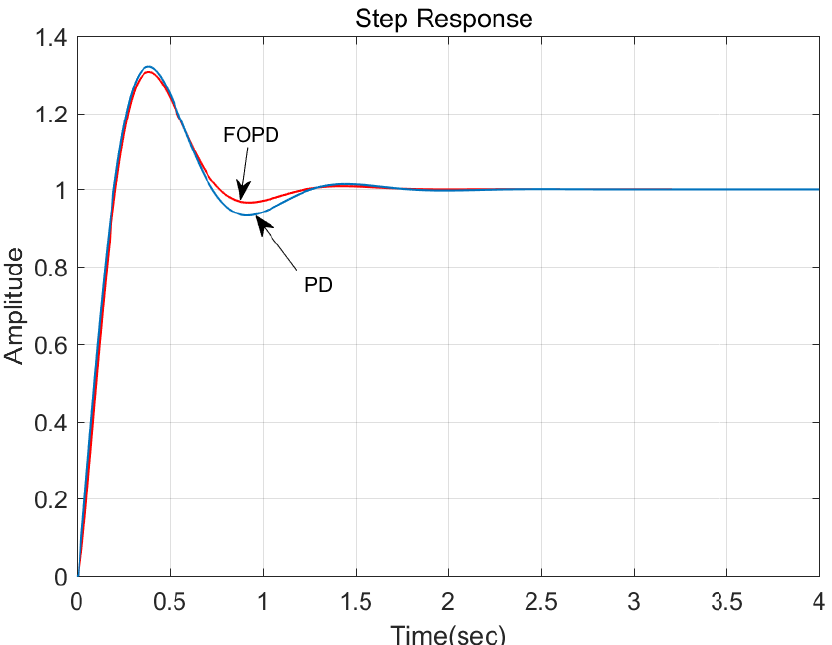
Figure 7. Step responses under fractional-order and integer-order PD controllers (abbreviated as FOPD and PD,